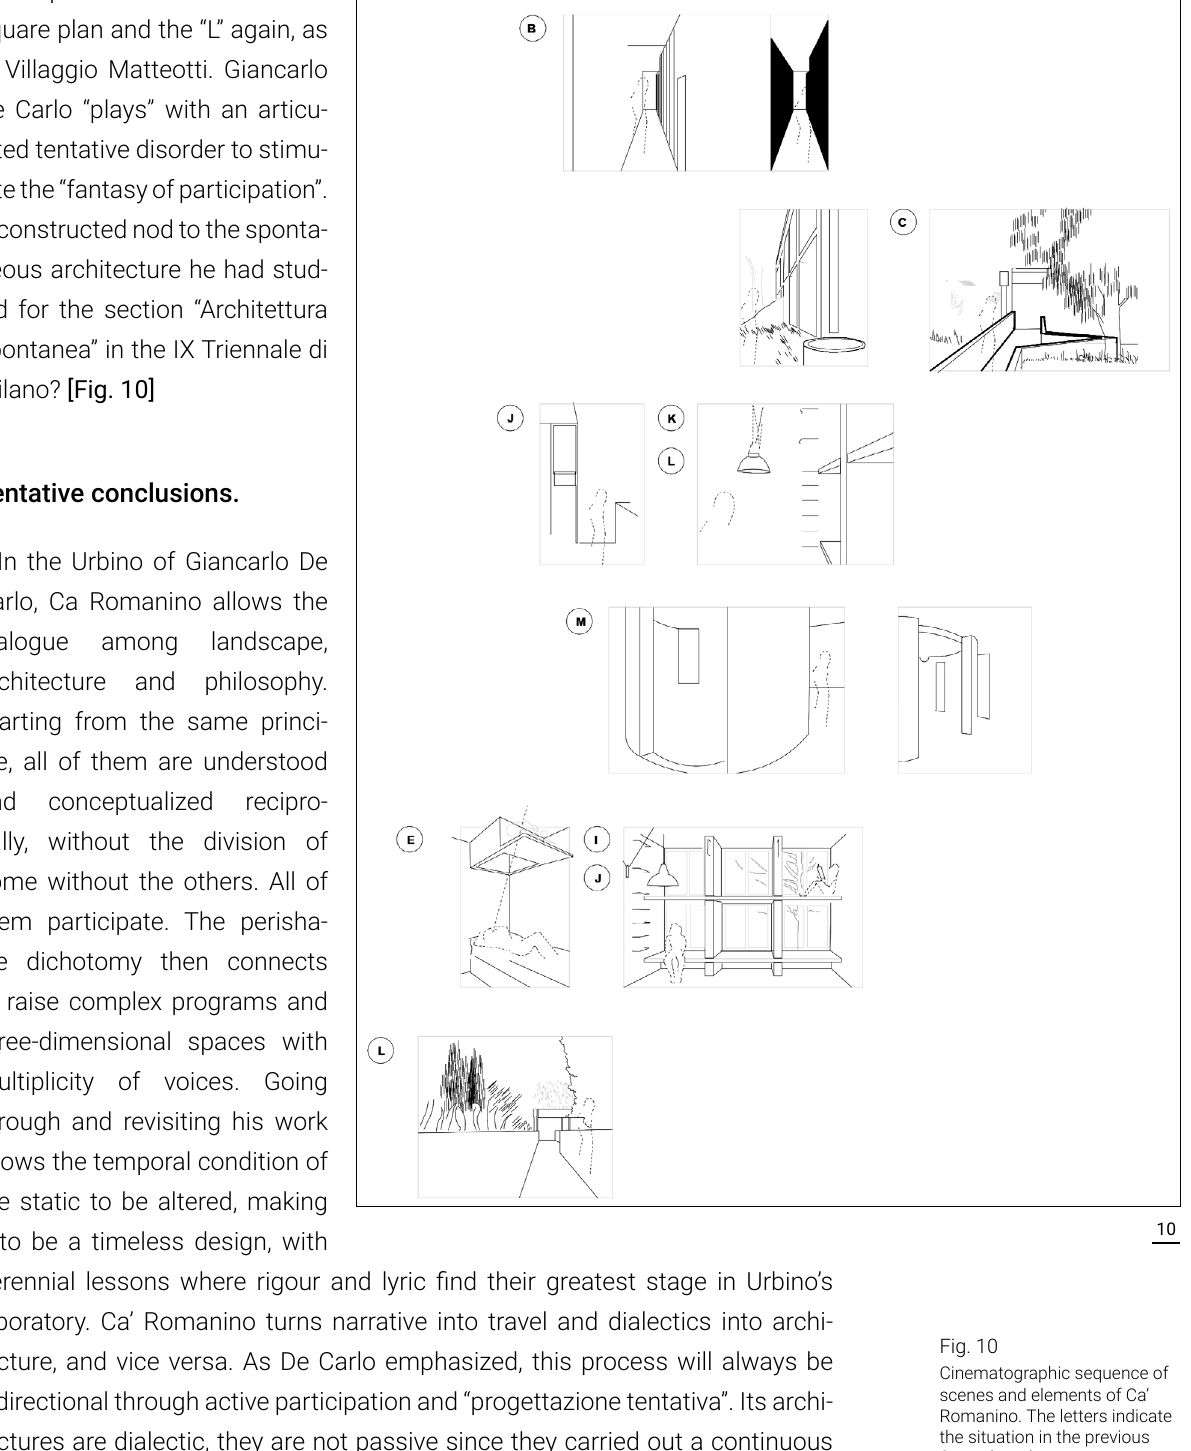
Fig. 10 Cinematographic sequence of scenes and elements of Ca’ Romanino. The letters indicate the situation in the previous figure (Fig.7). Source: Diagrams of the author based on